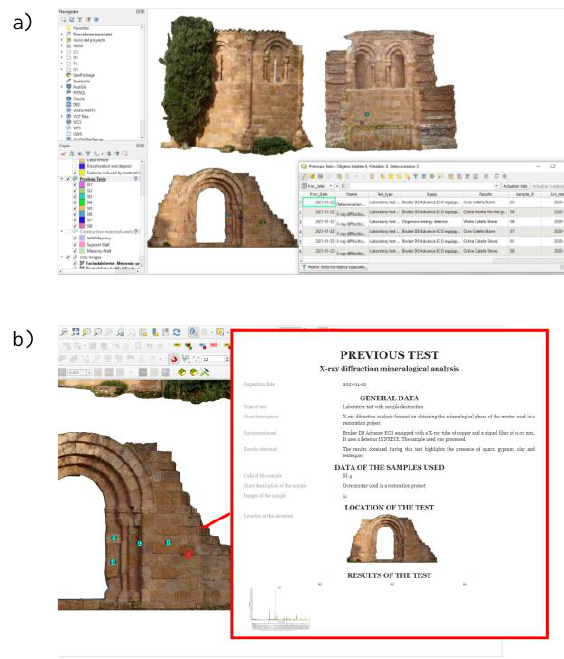
Figure 14. Previous test within the QGIS project: a) appearance of the shapes and; b) standardized HTML file of the X-ray